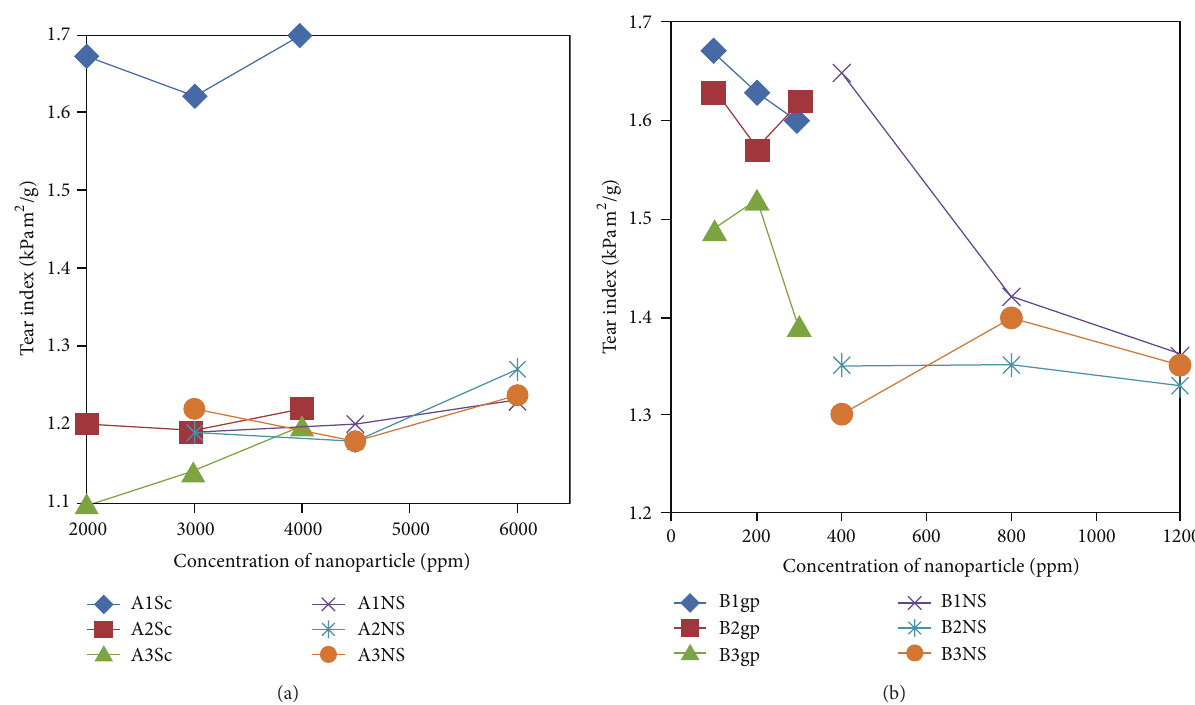
Figure 5: Effect of NS substituting for (a) Sc or (b) gp on the tear indices of the resulting